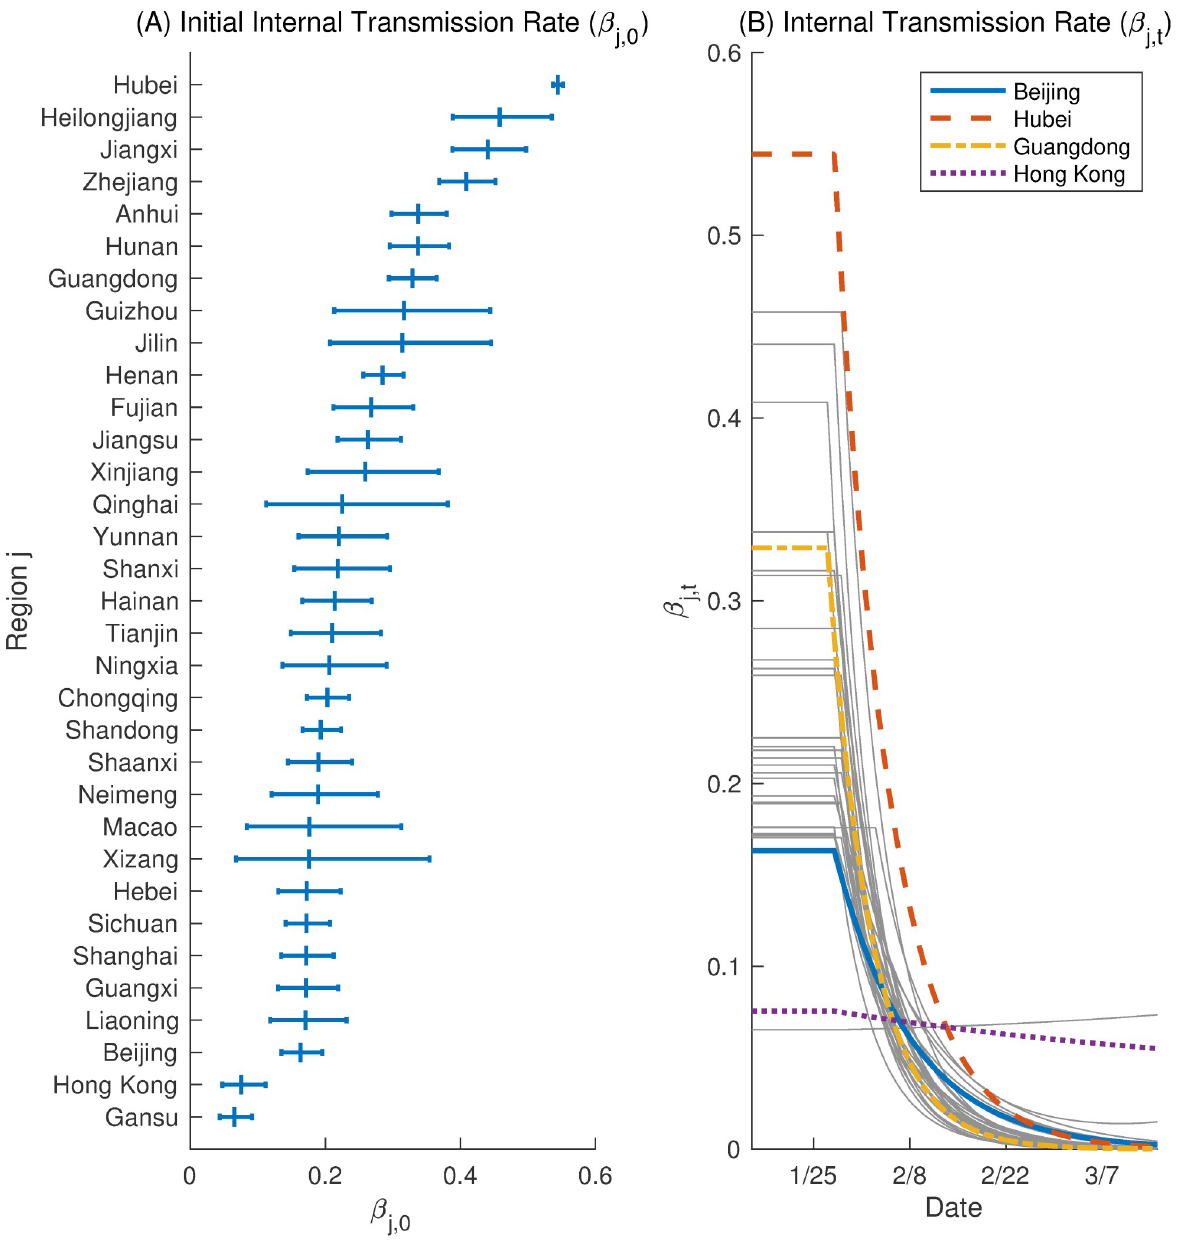
Fig 2. Internal transmission rate. Panel (A) shows that the posterior mean of the basic reproduction number for each region with the line segment representing the 95% posterior credible interval. Panel (B) reports the posterior mean of the effective reproduction number ( R t ) across regions over